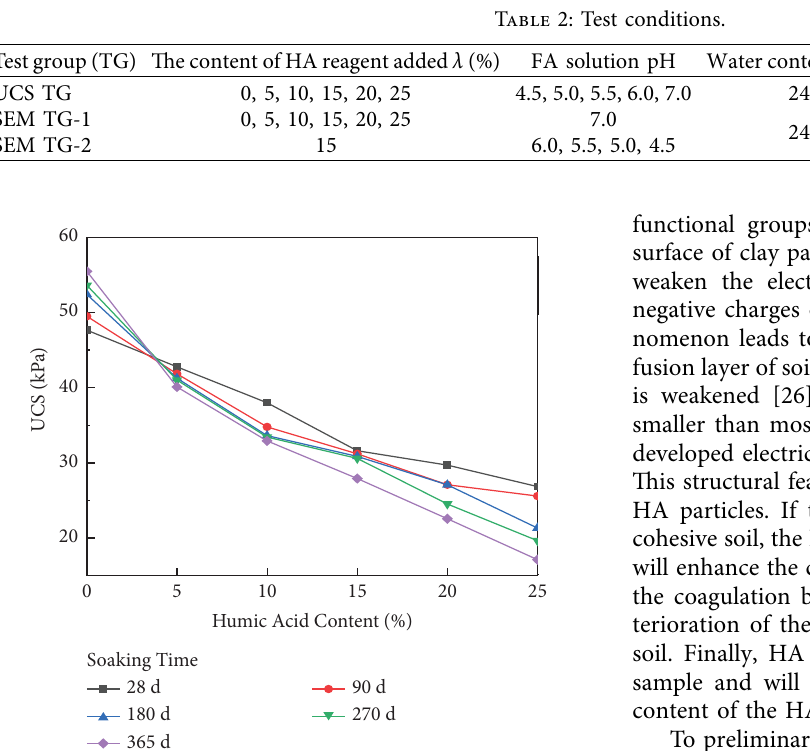
Figure 3: Relationship curve between sample UCS and the content of HA